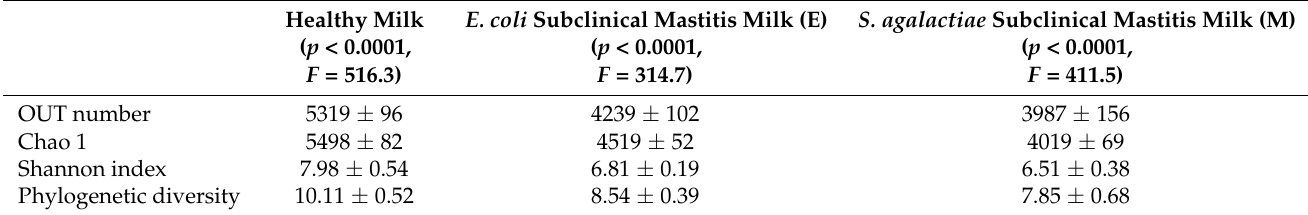
Table 2. Analysis of the alpha-biodiversity of the bacteria present in the analyzed milk samples.